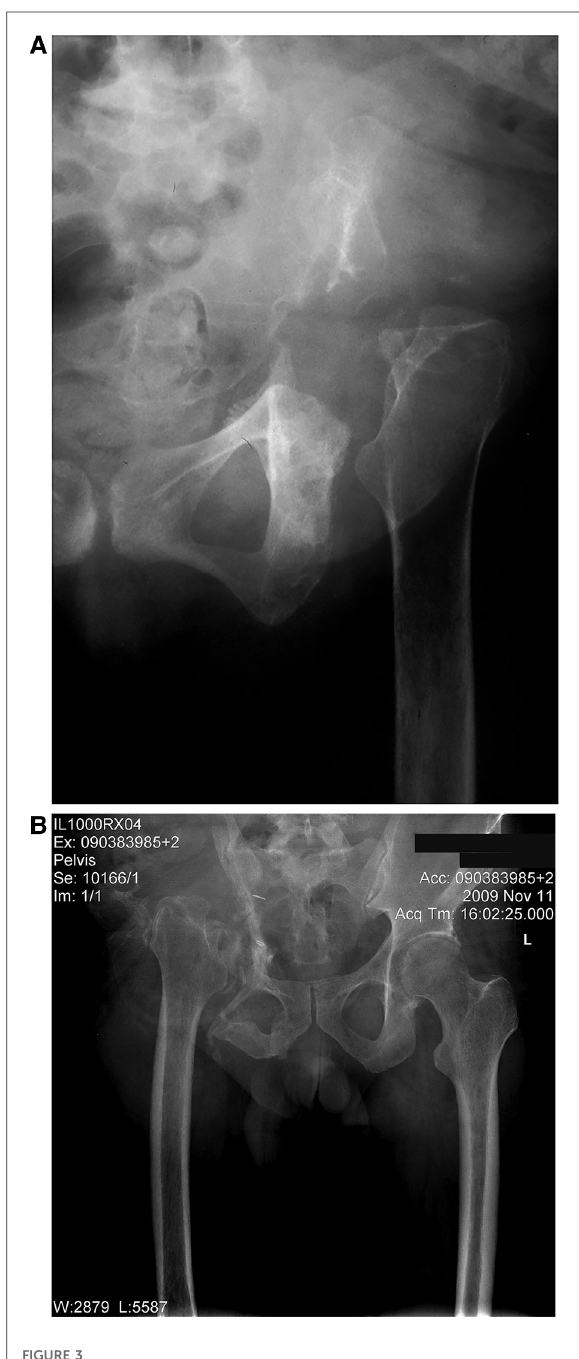
FIGURE 3 ( A,B ) plain anterior-posterior (AP) radiograph of the hemipelvis showing proximal migration of the operated extremity after bone tumor resection following six weeks of weight bearing. ( A ) shows the left hemipelvis, and ( B ) the right